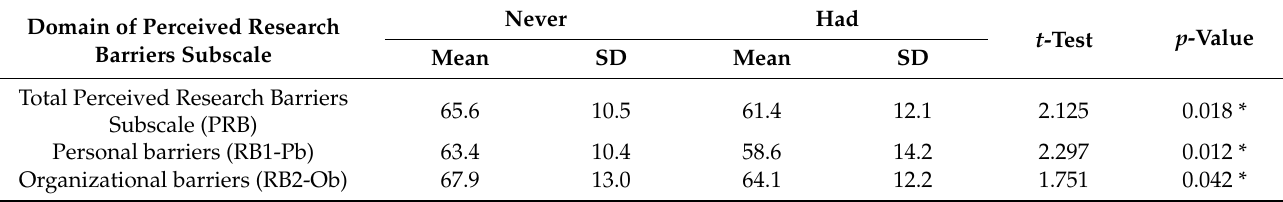
Table 5. Association between PRB and research implementation.